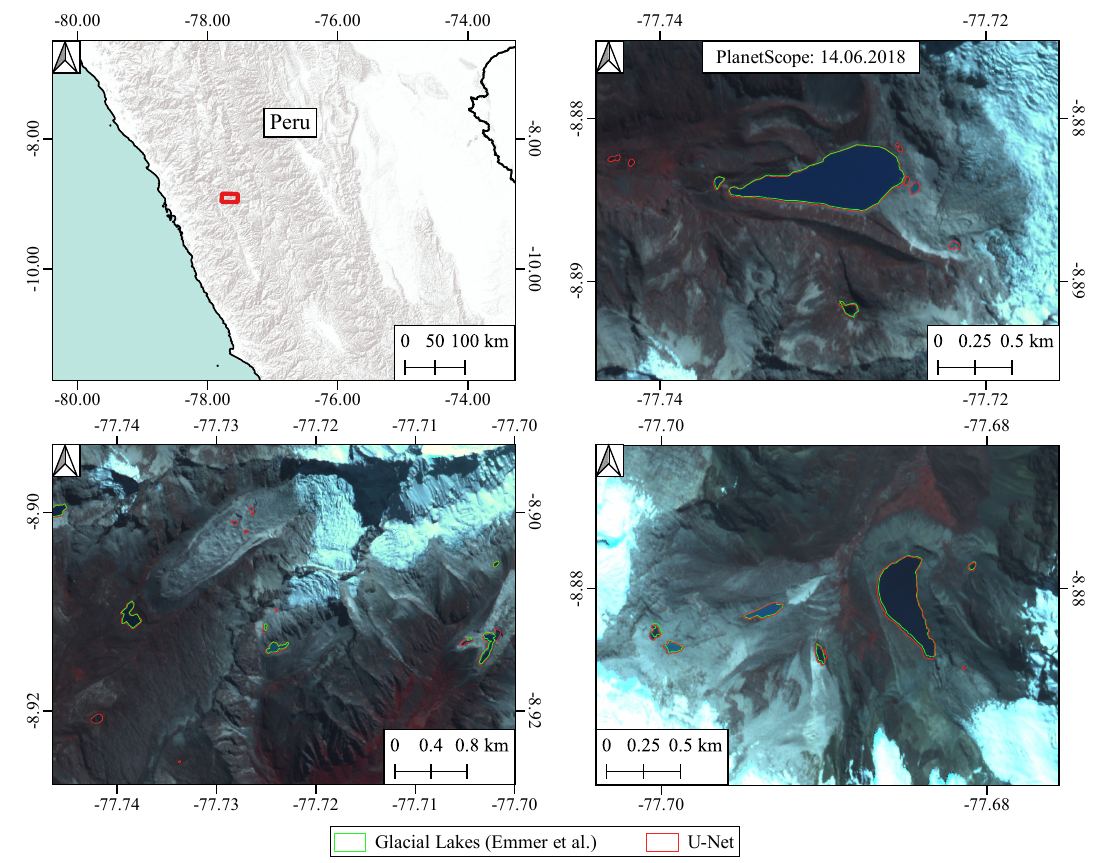
Figure 17. Mapping of the glacial lakes in the Peruvian Andes using PlanetScope imagery and the U-Net model, which was trained on the data from the Hindu Kush, Karakoram and Himalaya (HKKH) region. For a comparison, lake outlines from Emmer et al. [65] are also